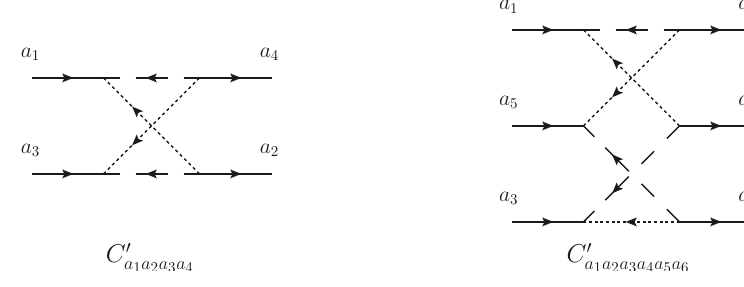
Figure 3 . Box and exagon diagram contributing to 2 and 3 loops order, with their color